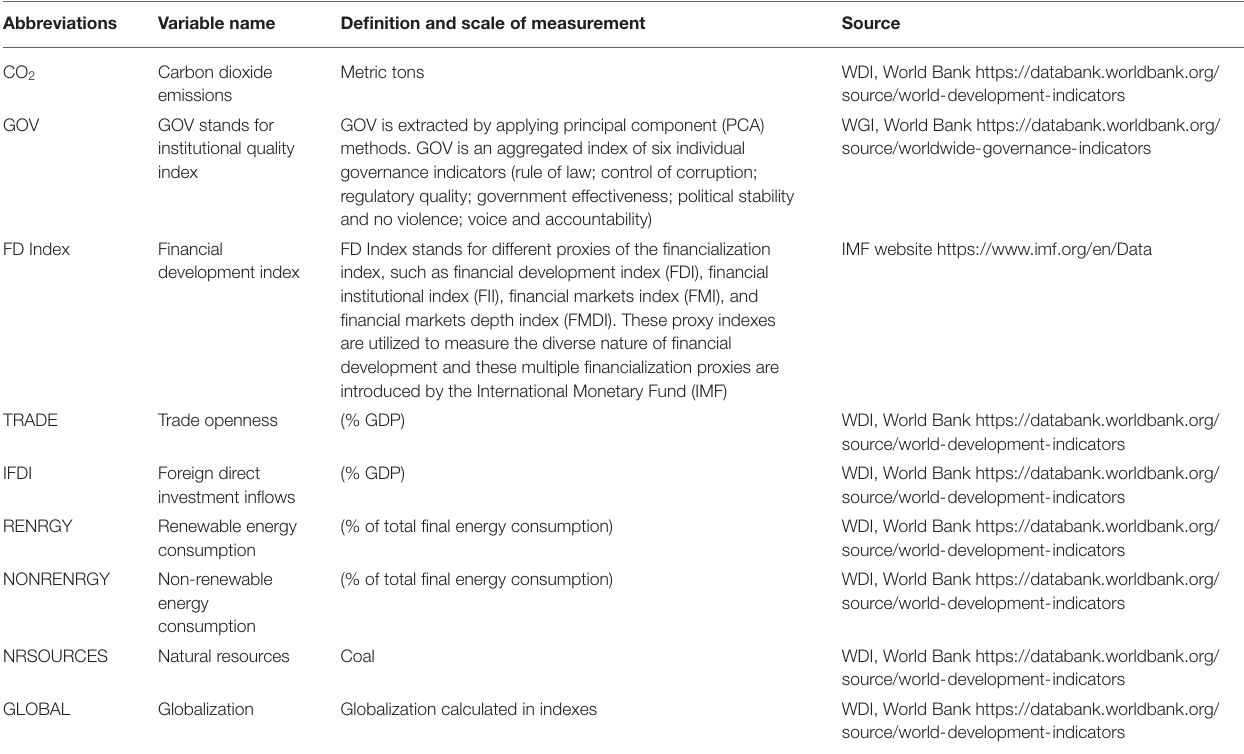
TABLE 1 | Variables description.